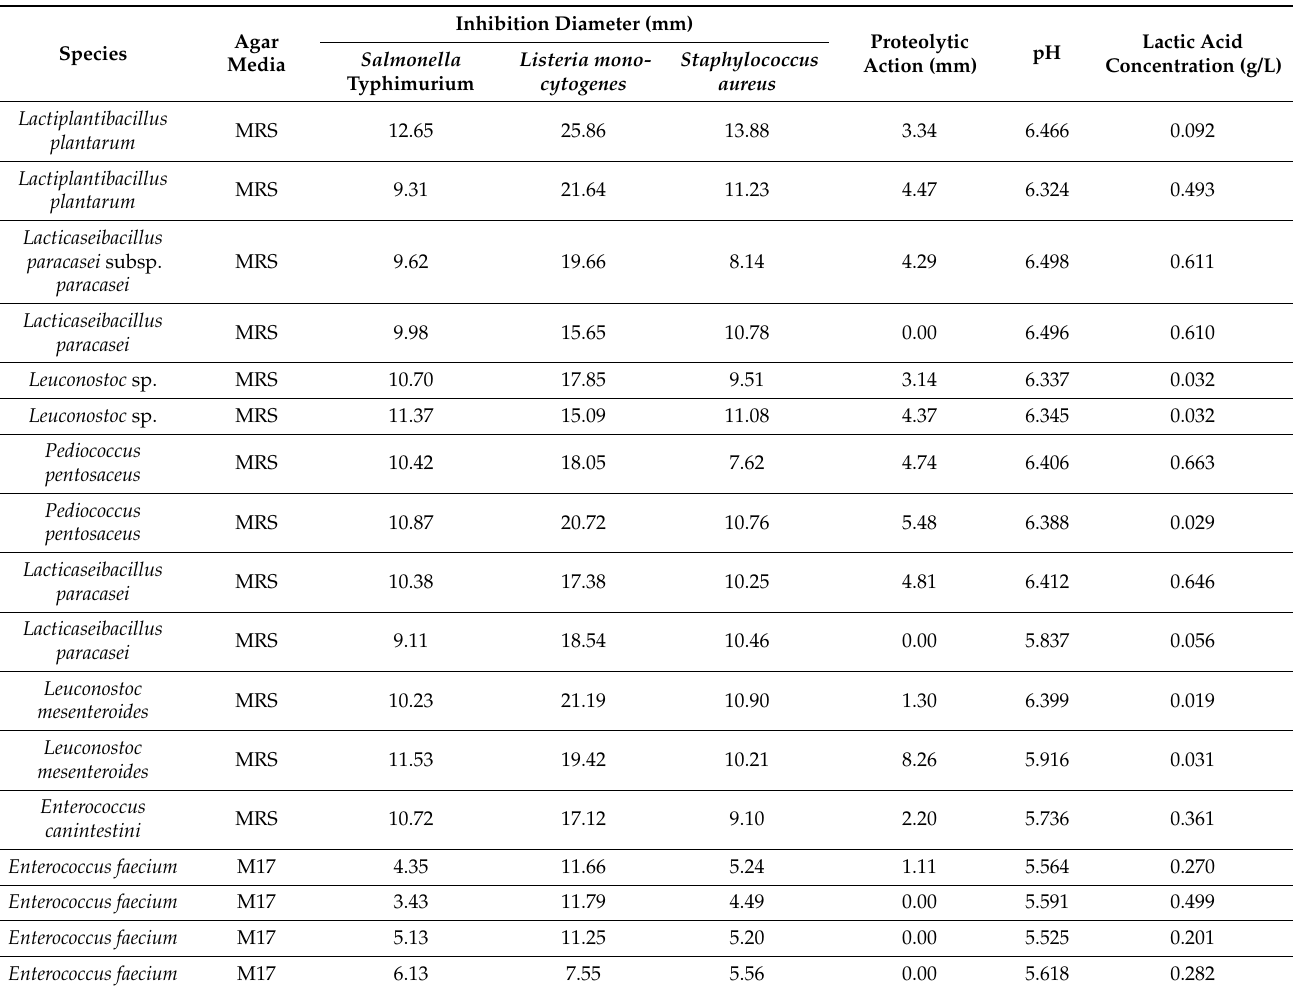
Table 1. Physicochemical properties and growth media of lactic acid bacteria isolated from Portuguese alheira sausage, along with the corresponding identified